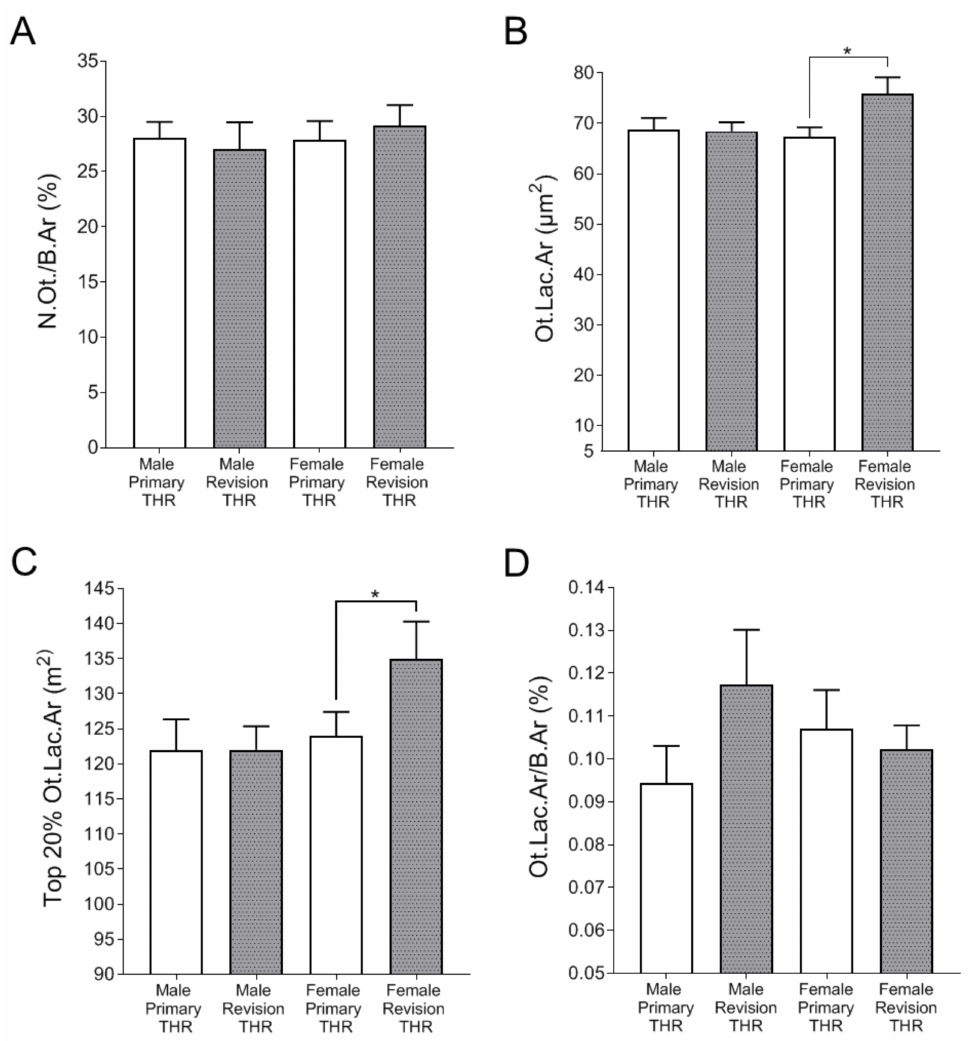
Figure 5. Gender-specific analysis of osteocyte lacunar properties: ( A ) osteocyte number per bone area (N.Ot. / B.Ar (%)) for Male Primary THR, Male Revision THR, Female Primary THR and Female Revision THR biopsies; ( B ) average lacunar area (Ot.Lac.Ar ( µ m 2 )); ( C ) the top 20% lacunar area (top 20% Ot.Lac.Ar ( µ m 2 )) for each cohort; ( D ) The percentage lacunar area per total bone area in all cohorts (Ot.Lac.Ar / B.Ar (%)). Data shown are means ± standard error of the mean (SEM). Significant di ff erences are denoted by * p <